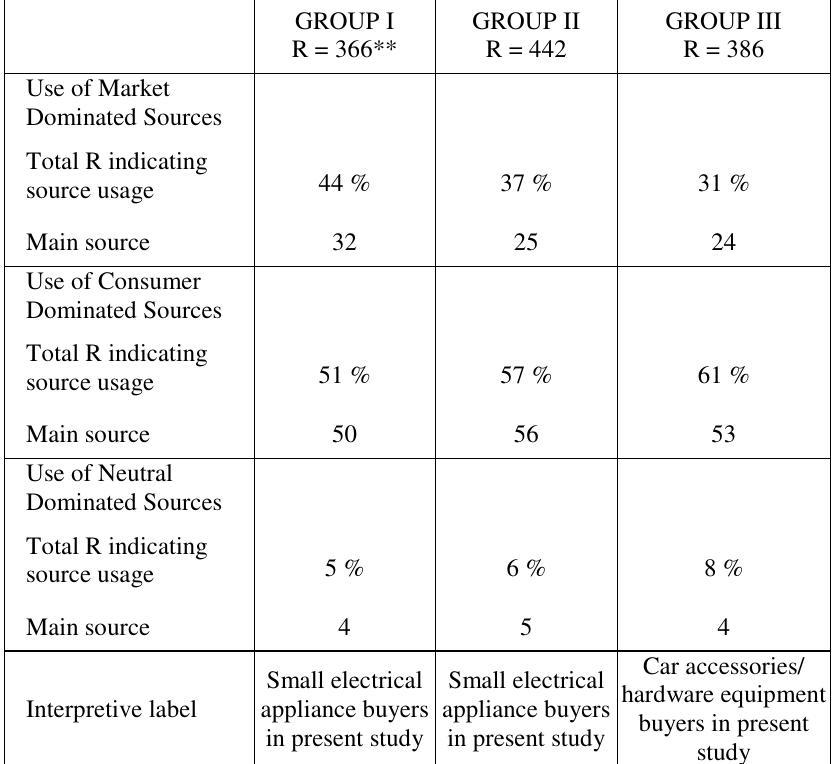
PATTERNS OF INFORMATION SOURCE USAGE EXPRESSED AS PERCENTAGE RESPONSES BY SAMPLE